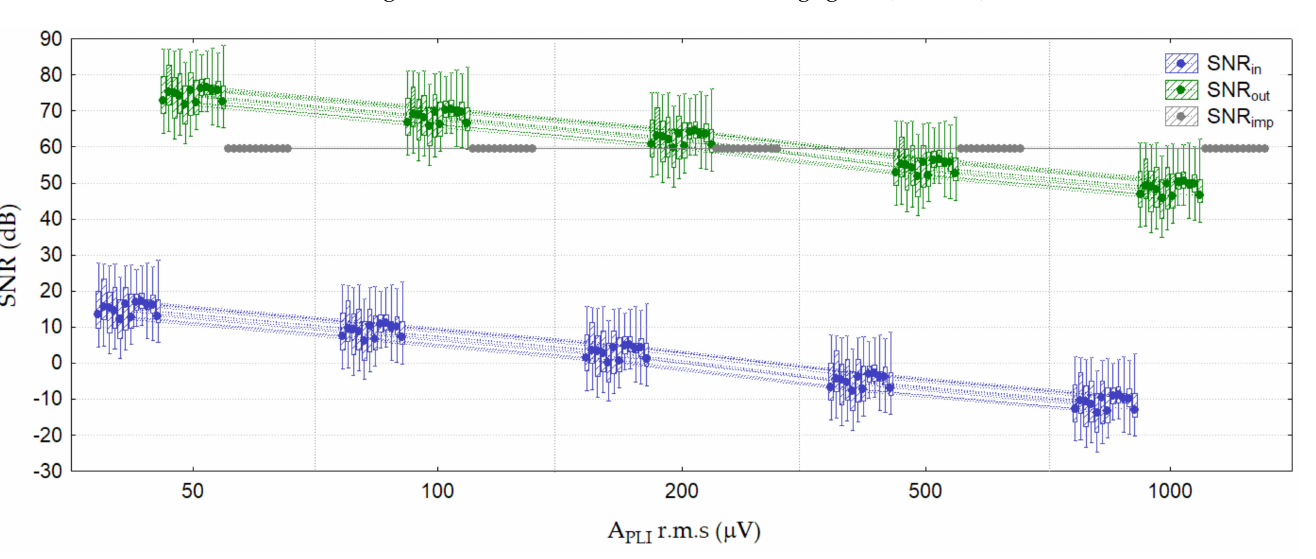
Figure 9. SNR characteristics for PLI constant (amplitude test), computed for 10 s 12-lead ECG